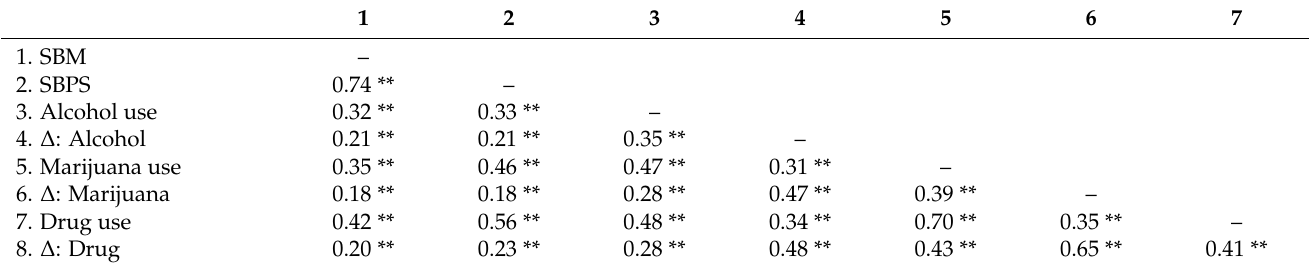
Table 4. Correlations Between Boredom, Substance Use, and Changes in Substance